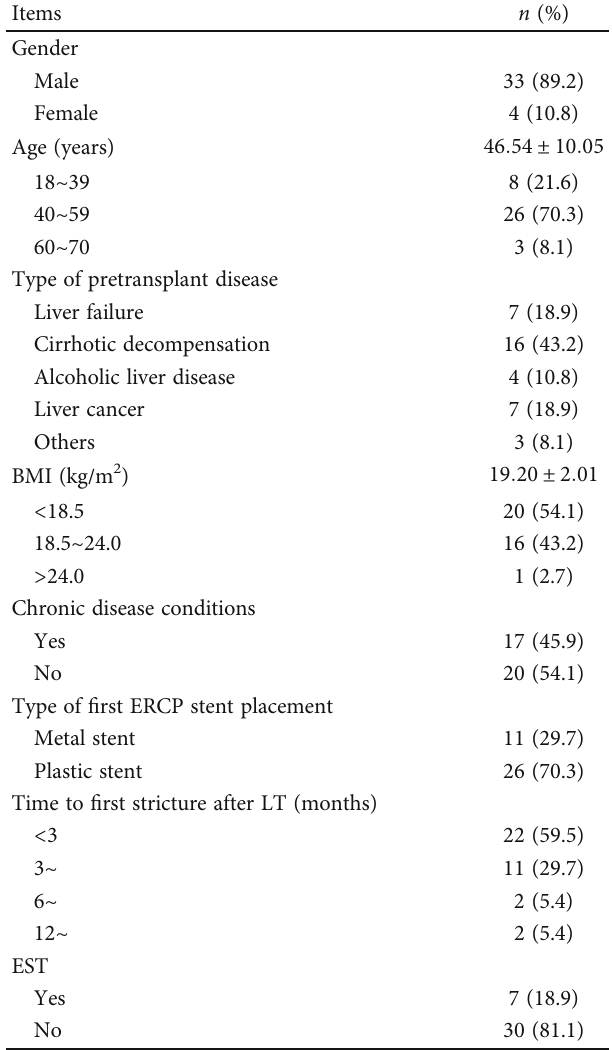
Table 1: The characteristics and clinical details of study subjects.